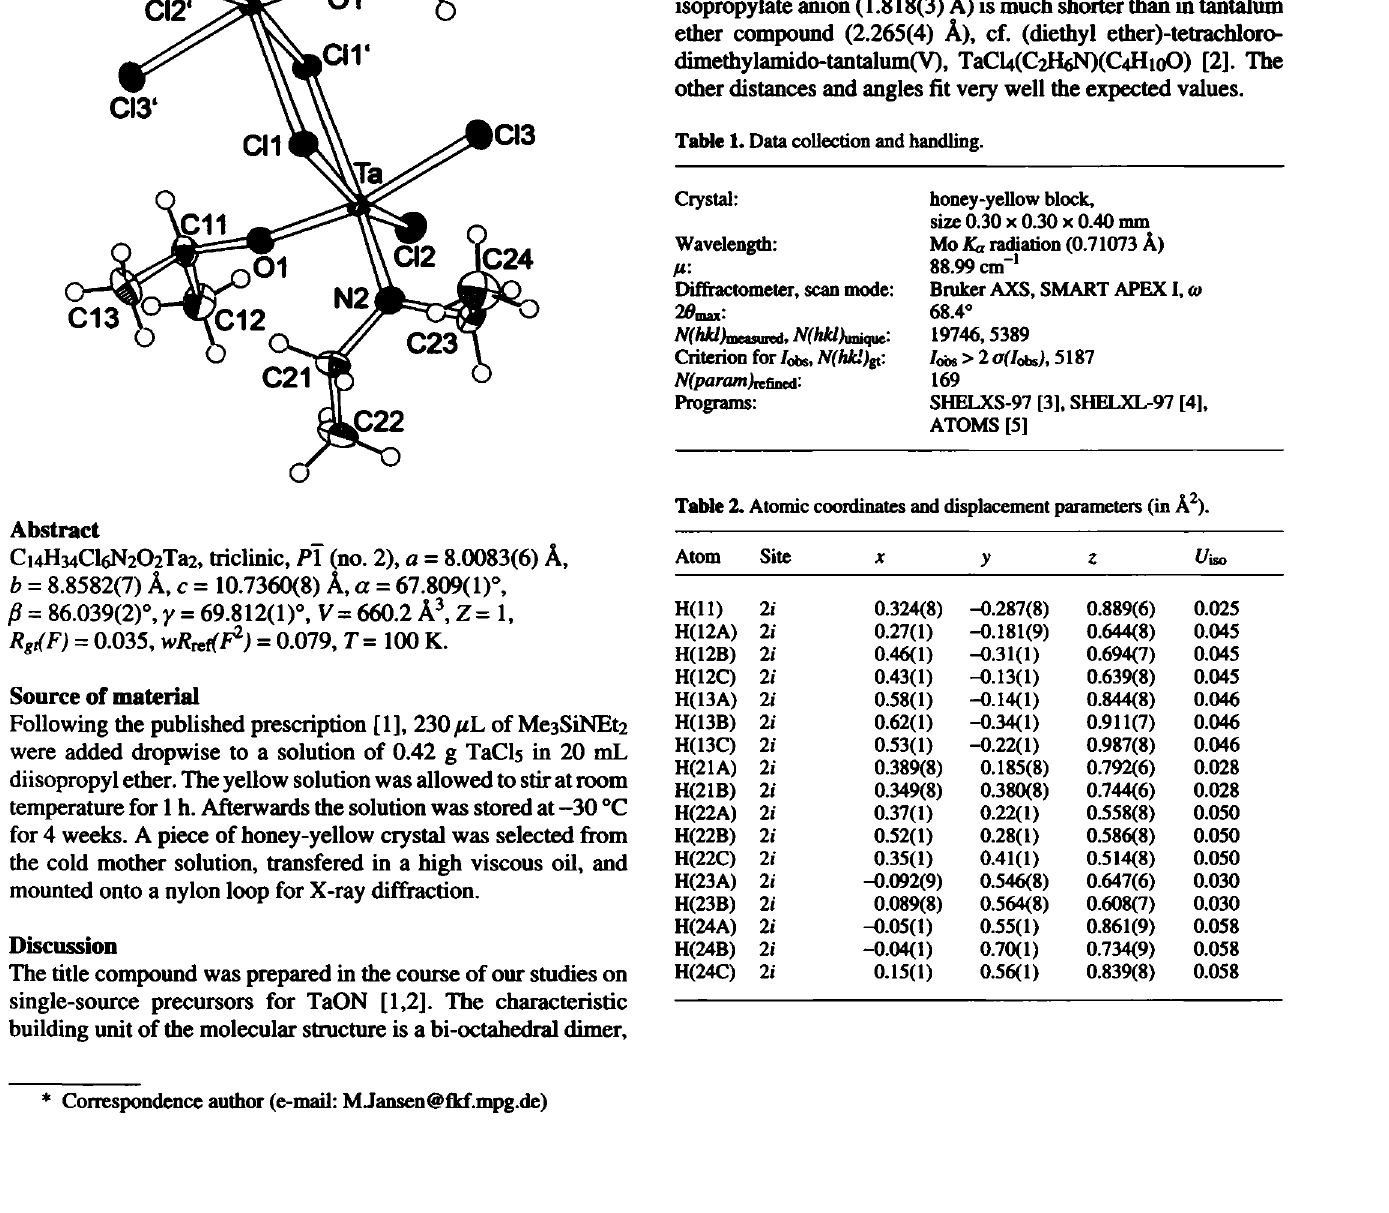
Table 1. Data collection and handling.